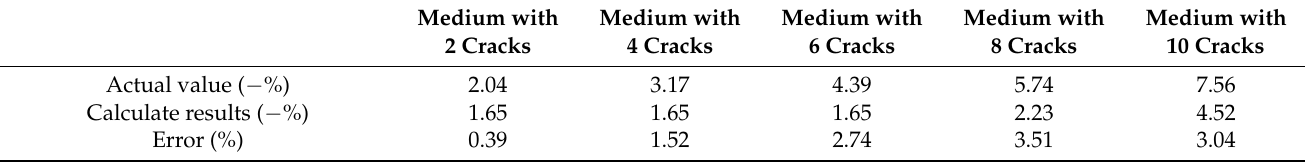
Table 1. The actual and calculated wave velocity change rate calculated with the first arrival wave. Medium with Medium with Medium with 2 Cracks 4 Cracks Calculate results ( − %)